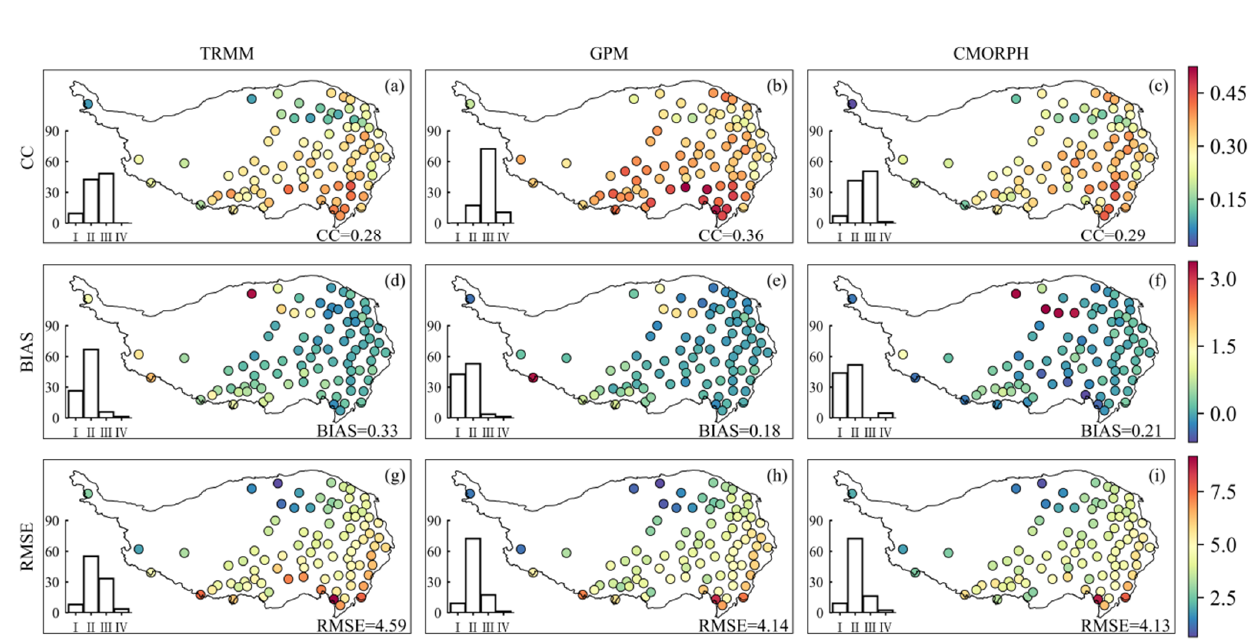
Figure 11. Spatial distribution of ( a – c ) CC, ( d – f ) BIAS and ( g – i ) RMSE for the three remote sensing precipitation products and the percentage of evaluation points in different intervals. I, II, III and IV indicate the different intervals of the indexes (see Table 2), and the marked numbers represent the average values of the evaluation indexes.